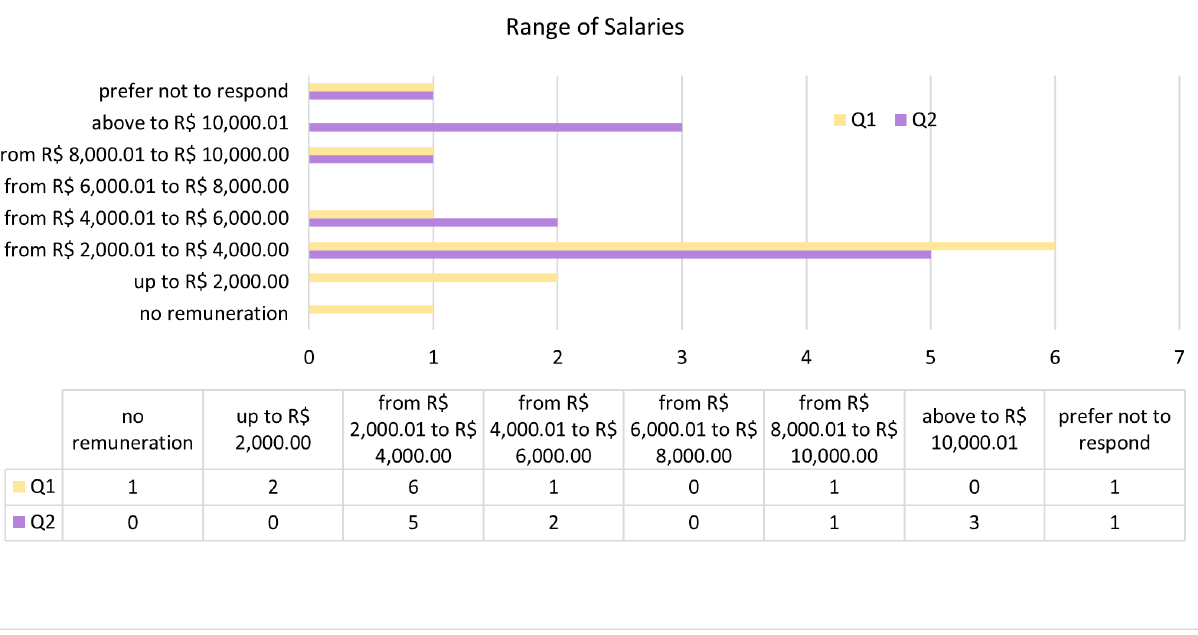
Figure 1. Range of Salaries (questionnaire 1 and questionnaire